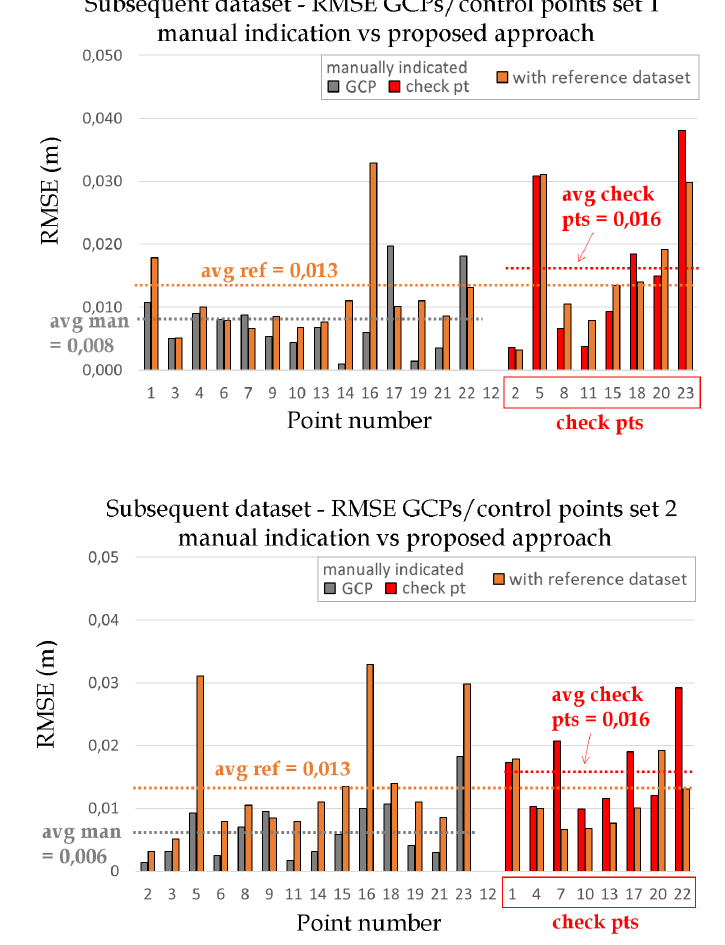
Figure 10. Subsequent datasets—ground control point RMSEs using the reference module versus obtained through manual indication of the points with two subsets of the points as check